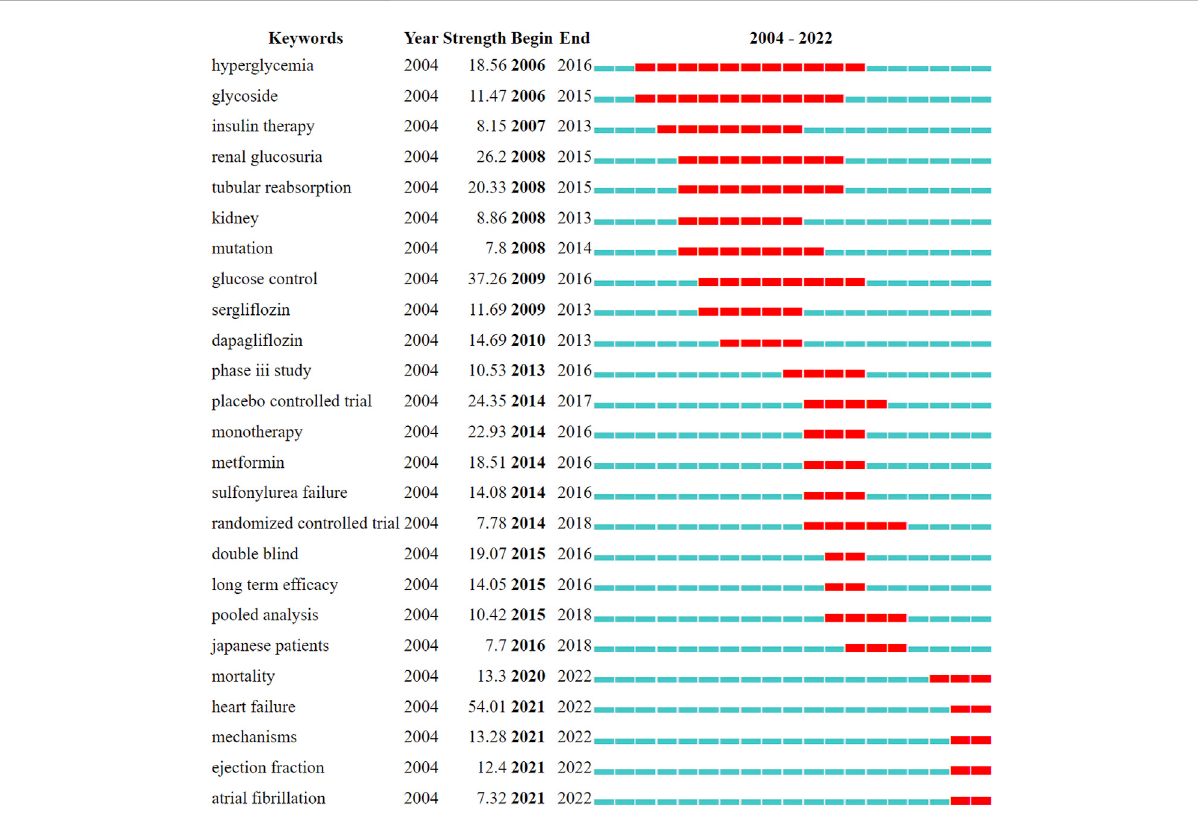
FIGURE 9 Top25keywordswithcitationburst(sortedbythebeginningyearoftheburst).Theyearsbetween “ Begin ” and “ End ” representtheperiodwhen the keyword was more in fl uential. The dark blue bar represents the year in which the keyword appeared, and the red bar refers to the burst duration. Burst strength indicates the importance of keywords to the research fi